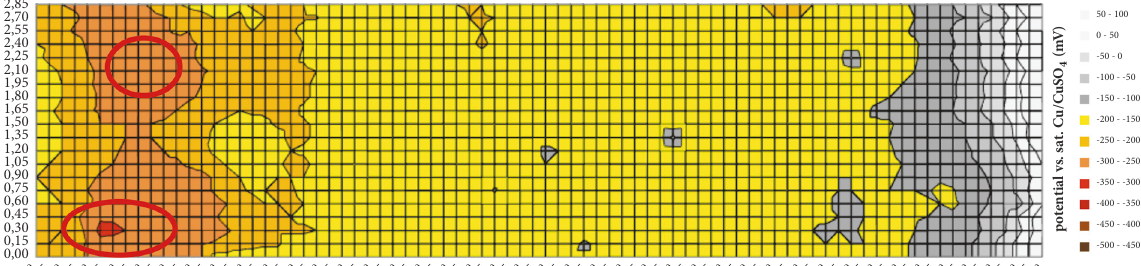
Figure 5: Potential mapping results of the large-scale specimen—two anodes.